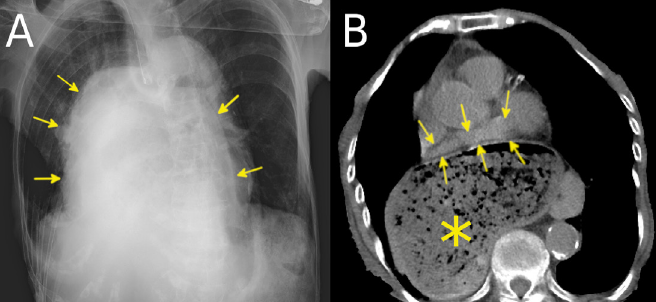
Image. (A) Chest radiograph showing a mass shadow on the right side of the mediastinum (arrows). (B) Computed tomography of the chest in axial view showing displacement of the left atrium (arrows) by a giant esophageal hiatal hernia